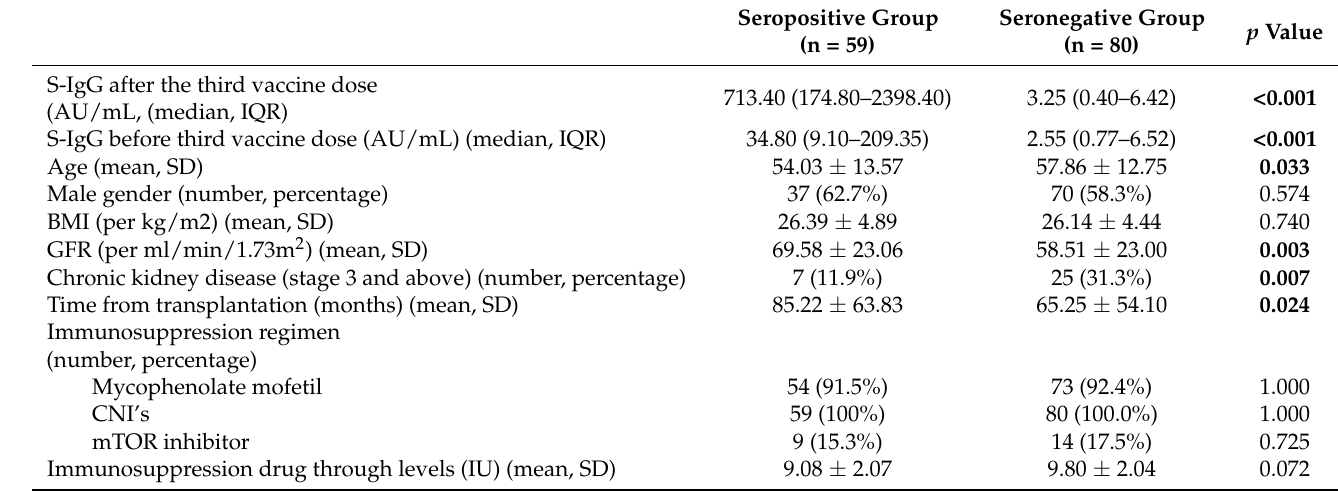
Table 1. Demographic and clinical characteristics of study participants, strati fi ed by seropositivity to anti-spike IgG antibodies after three vaccine doses.